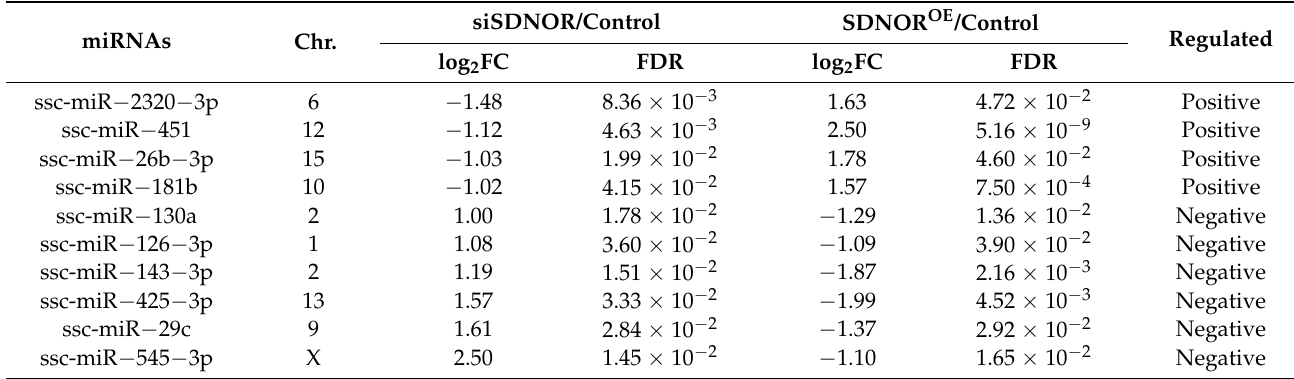
Table 2. SDNOR-regulated DEmiRNAs in porcine